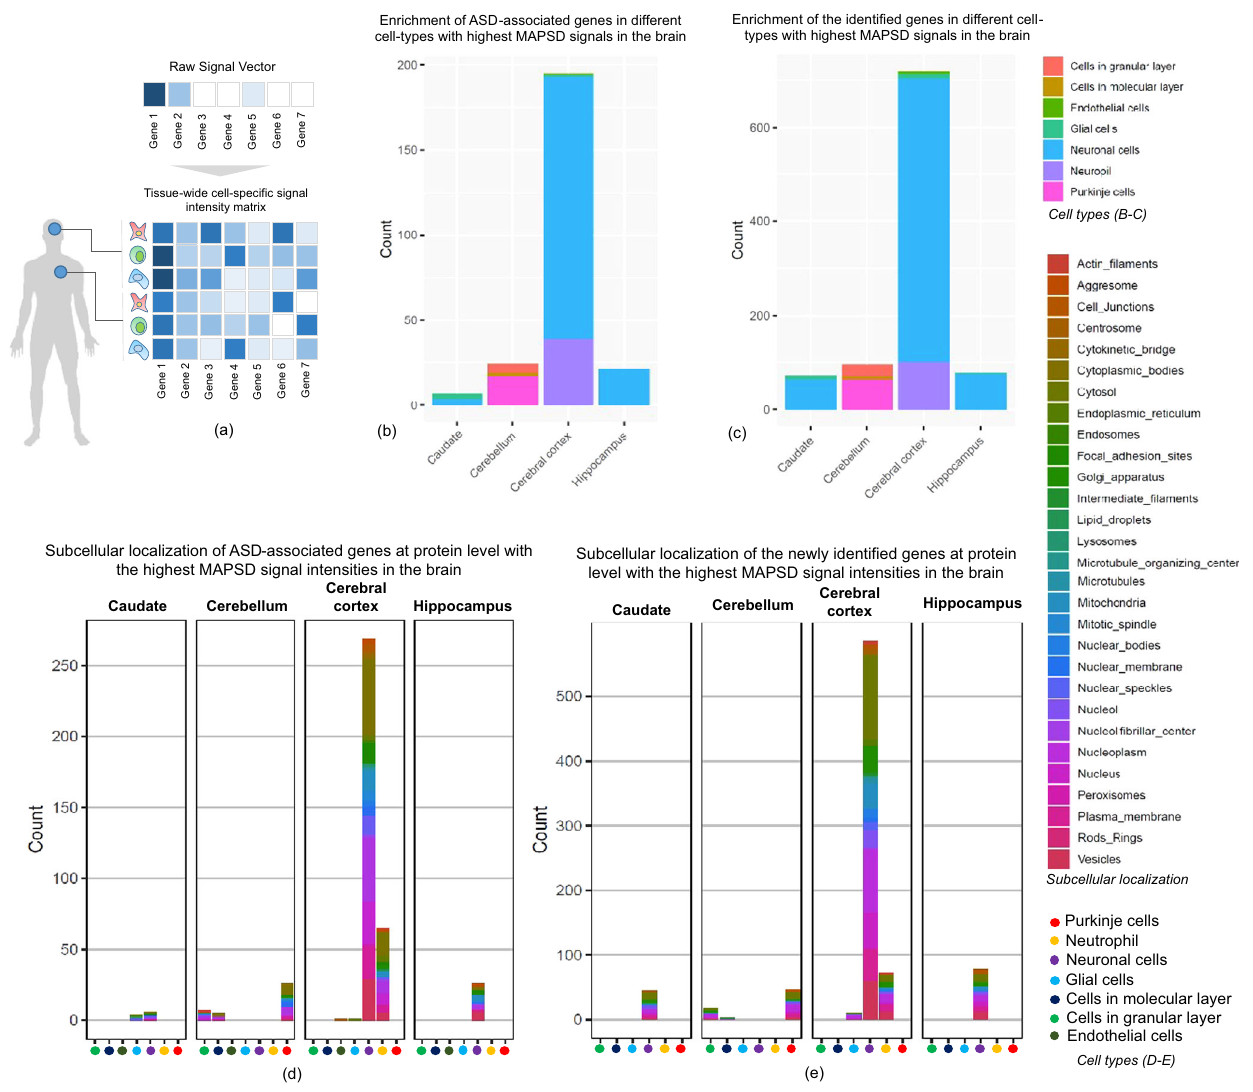
Fig. 1 A schematic of MAPSD and Enrichment patterns of MAPSD brain-speci fi c gene-encoded proteins at cell resolution and subcellular domains using the Human Protein Atlas data. a A schematic of MAPSD which starts with raw signal vector of a gene list and diffuses them onto 131 combinations of tissues and cell-types given the structural topology of the PPI network and biochemical and biophysical properties of proteins. Darker cells represent high intensity genes regarding a speci fi c cell, vice versa; b Enrichment of MAPSD original ASD risk genes at single cell resolution in four brain regions; c Enrichment of MAPSD newly identi fi ed ASD risk genes at single cell resolution in four brain regions; d Enrichment of MAPSD original ASD risk genes is various subcellular domains in fi ve cell-types across four different brain regions; e Enrichment of MAPSD newly identi fi ed ASD risk genes is various subcellular domains in fi ve cell-types across four different brain